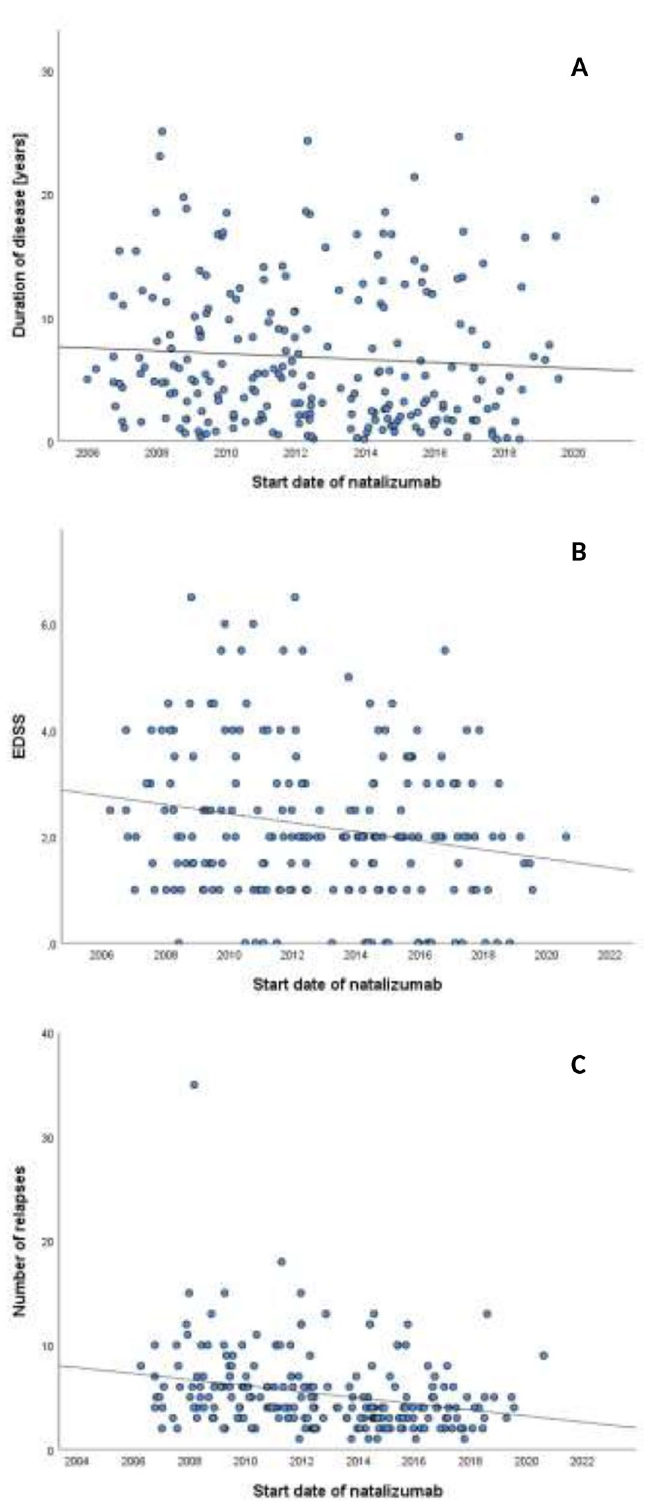
Figure 3. Scatter blots representing regression models of disease duration, EDSS score and number of relapses before start of NTZ over time. Linear regression models of disease duration ( A ), EDSS score ( B ) and number of previous relapses from disease onset ( C ) at time of NTZ treatment start from 2006 to 2020. EDSS score at NTZ treatment start and number of relapses before NTZ significantly decreased over time reflecting change of clinical practice. Significance (p) and Pearson correlation coefficient (r) of regression models: ( A ) p = 0.139, r = − 0.71. ( B ) p = 0.002, r = −0.198. ( C ) p < 0.001, r = −